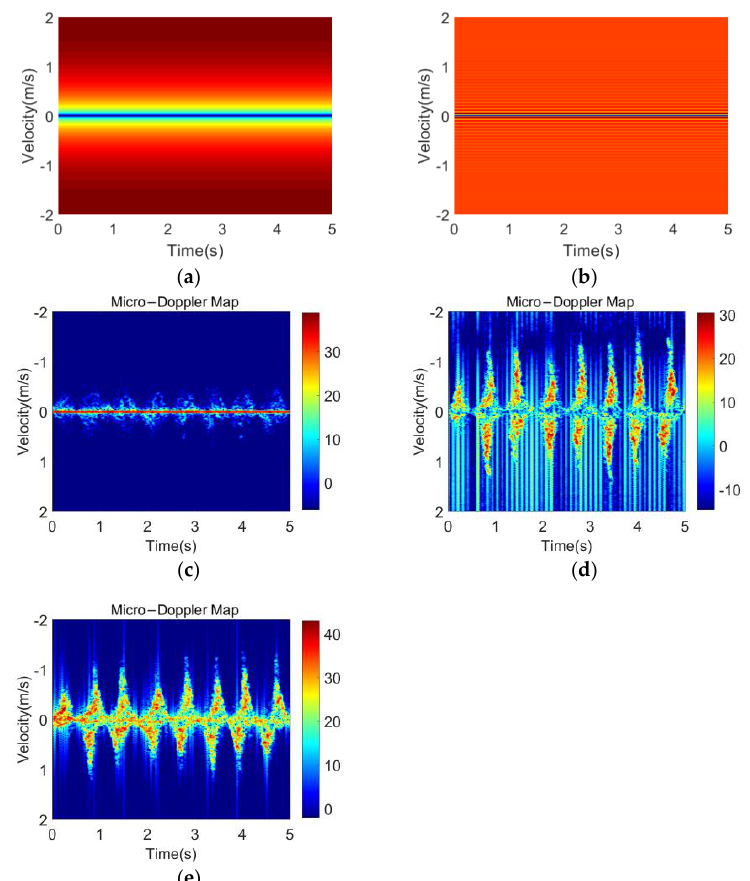
Figure 5. Comparison of the static clutter suppression methods in the walking state: ( a ) frequency response of MTI in the TF domain; ( b ) frequency response of the average cancellation in the TF domain; ( c ) MDM without static clutter suppression; ( d ) MDM after MTI; ( e ) MDM after the average cancellation.